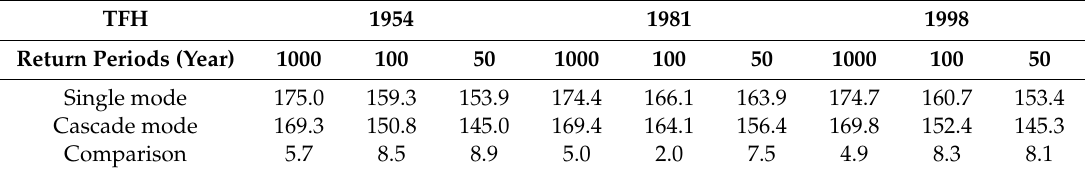
Table 6. The highest water level of Three Gorges Reservoir considering the flood control for the Jingjiang area (m).